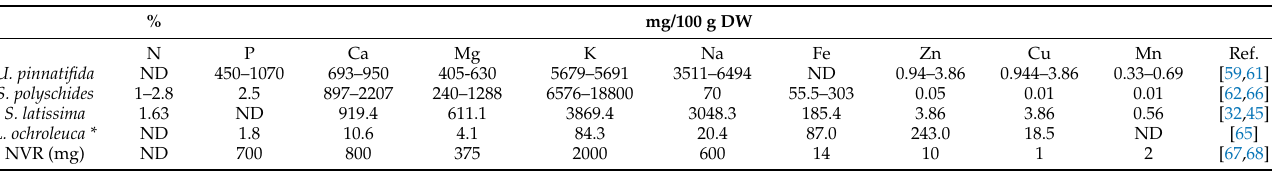
Table 8. Micronutrient and trace element composition of U. pinnatifida , S. latissima , L. ochroleuca , and S. polyschides according to the literature. ND—not determined.